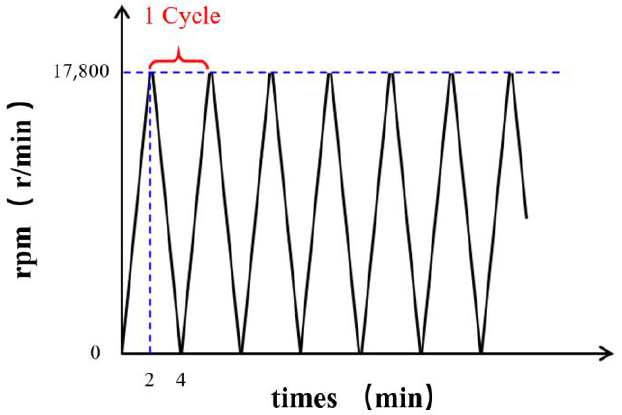
Figure 3. LCF load Figure 3. LCF load spectrum.